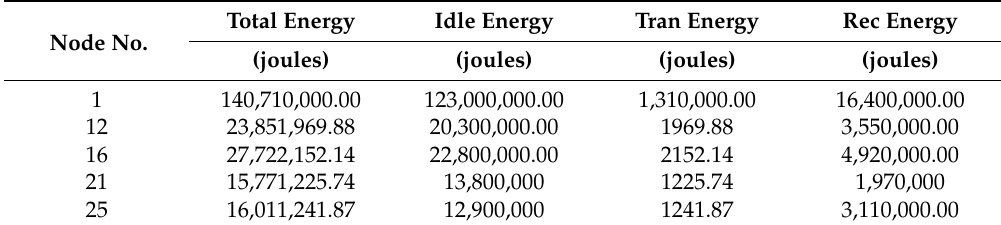
Table 9. Energy Measurements during rainfall on node 1.